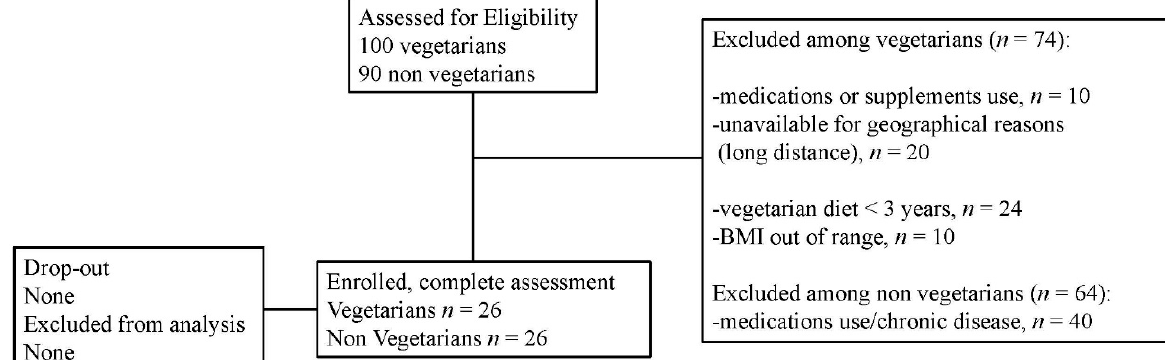
Figure 1. Flow diagram of participants. BMI, body mass index.